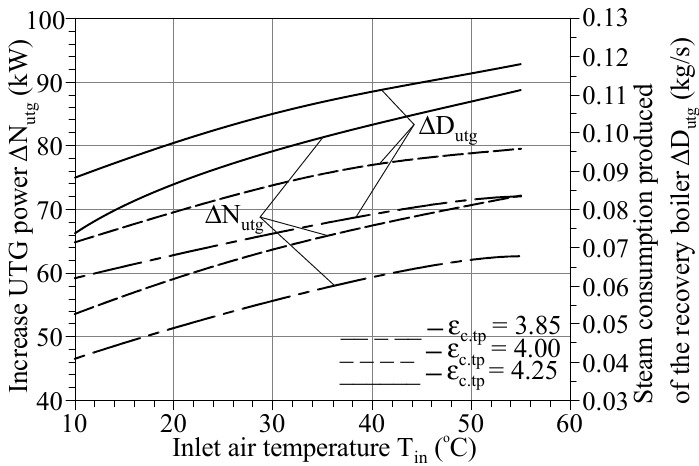
Figure 24. Dependences of the increase in UTG power ∆ N utg , increase in steam consumption produced in the recovery boiler of two pressures ∆ D utg at different total pressure increase ε c.tp on the inlet air temperature T in .